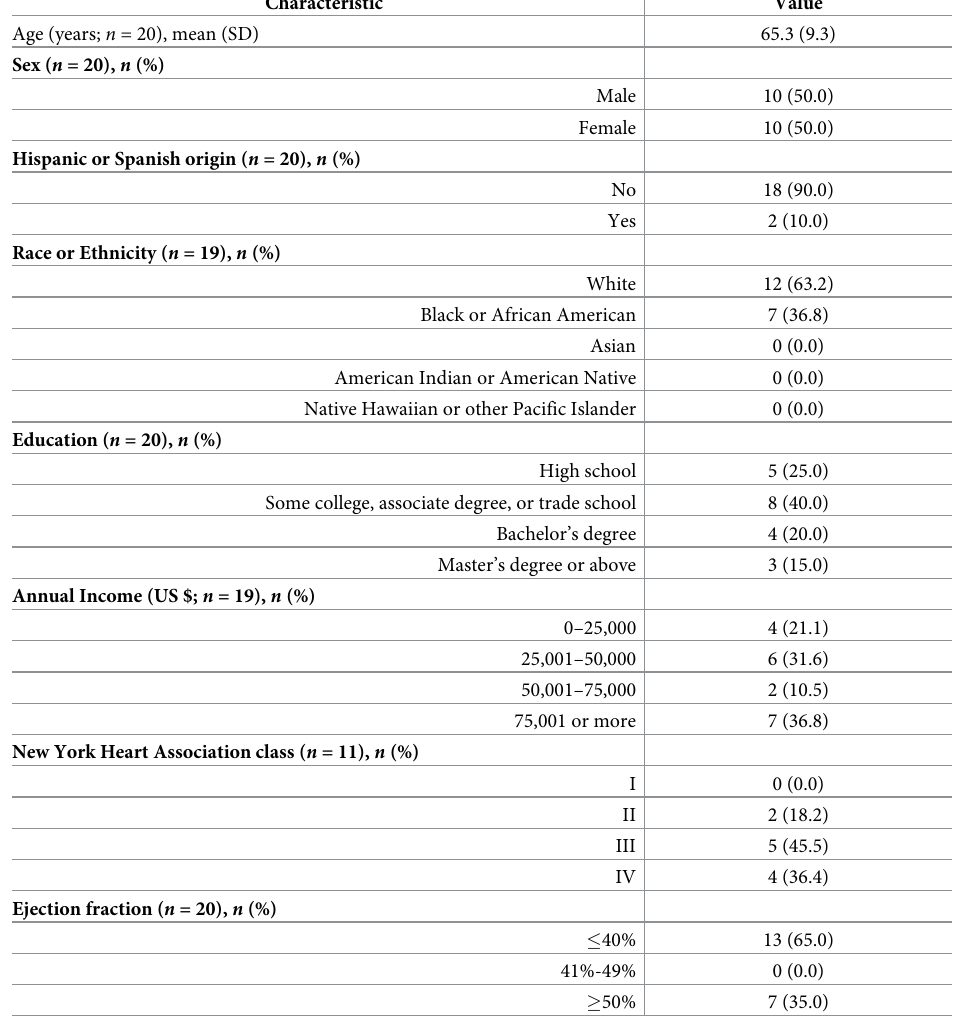
Table 2. Demographics of the study